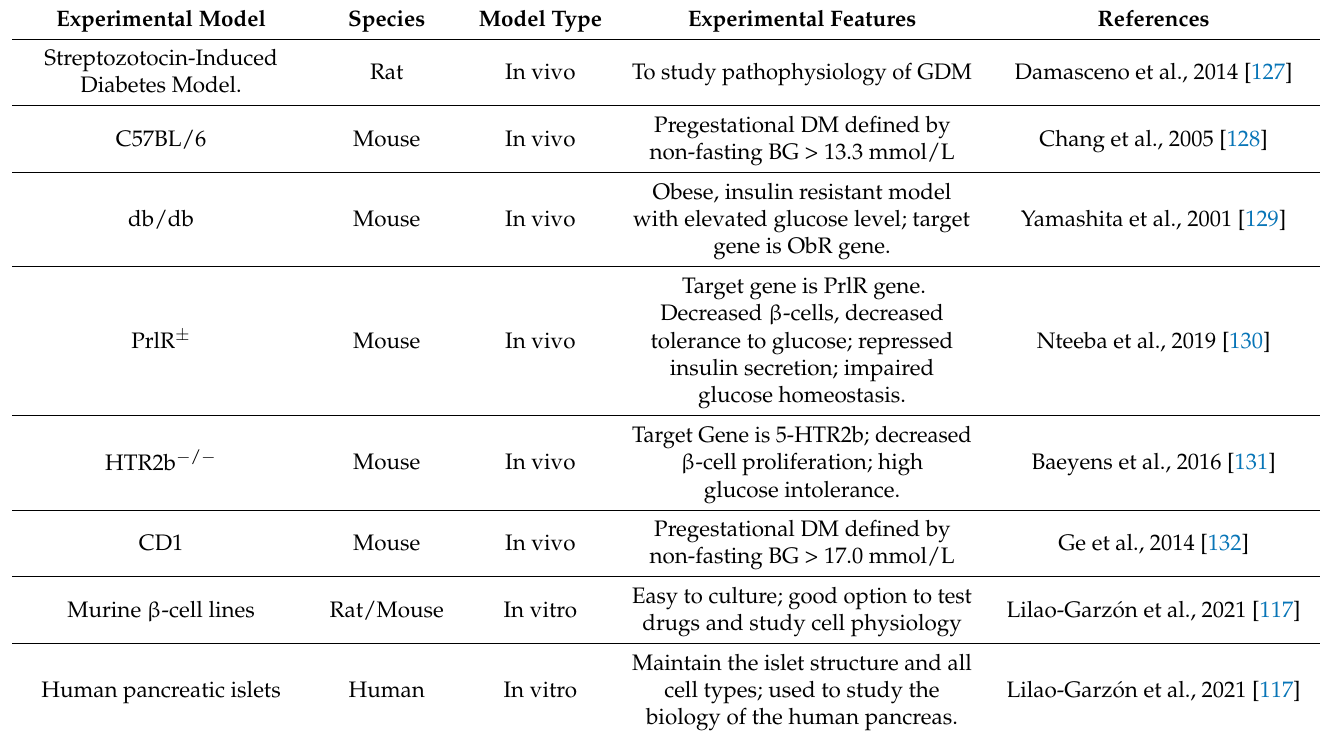
Table 2. In vivo and in vitro models relevant to GDM